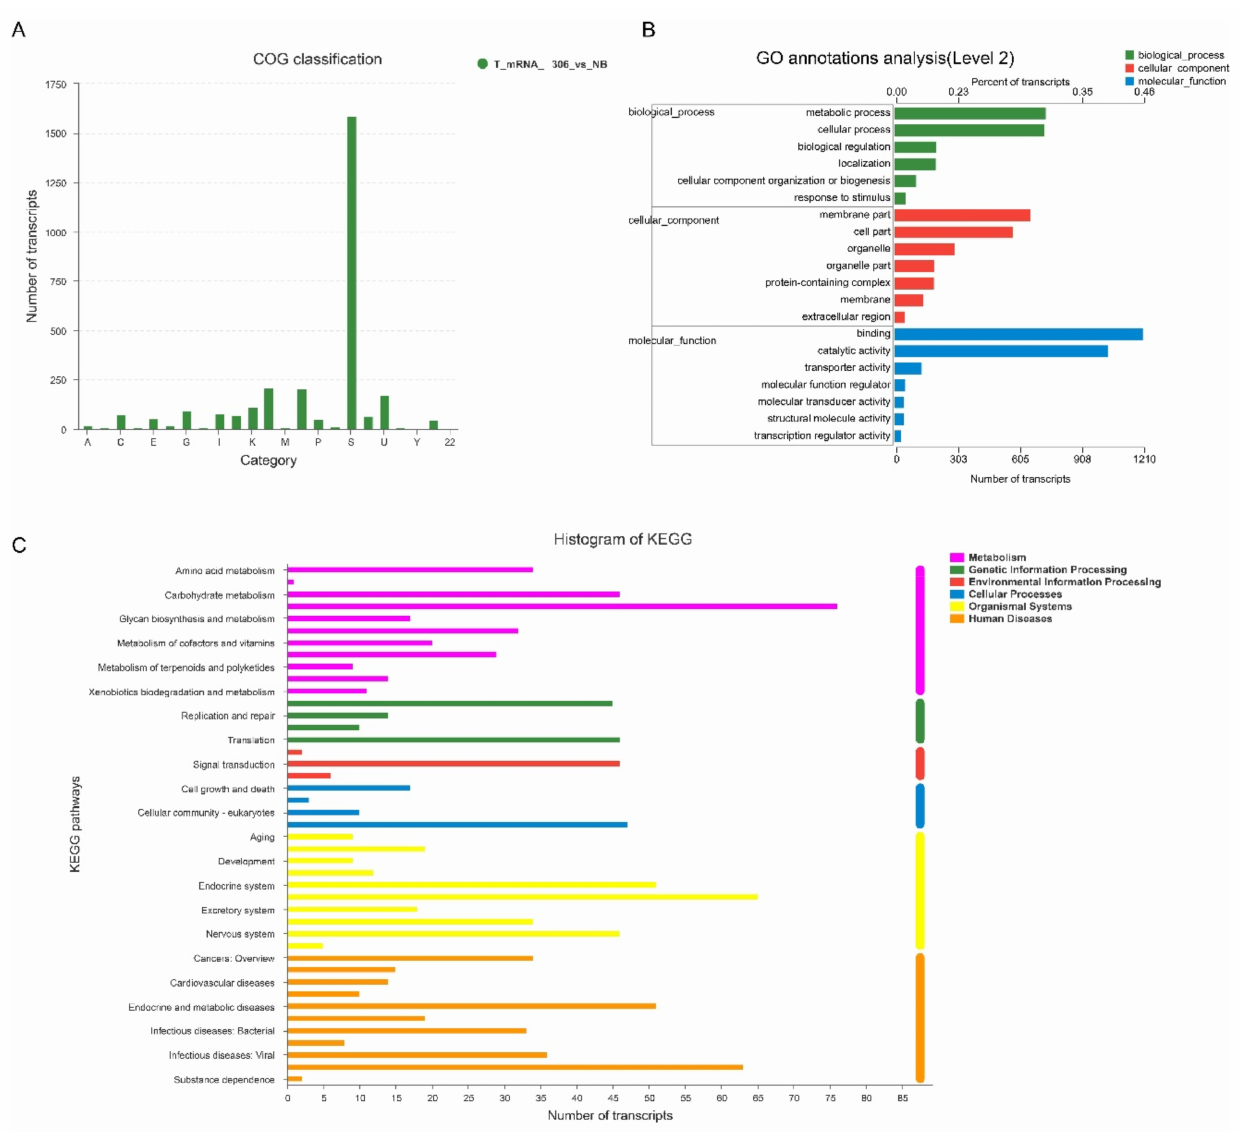
Figure 3. The COG, GO, and KEGG annotation of differentially expressed transcripts in the yellow cocoon silkworm NB compared with the white cocoon silkworm 306. ( A ) Clusters of Orthologous Groups of Protein (COG) classification; ( B ) Gene Ontology (GO) assignments; ( C ) Kyoto Encyclopedia of Genes and Genomes (KEGG) pathways